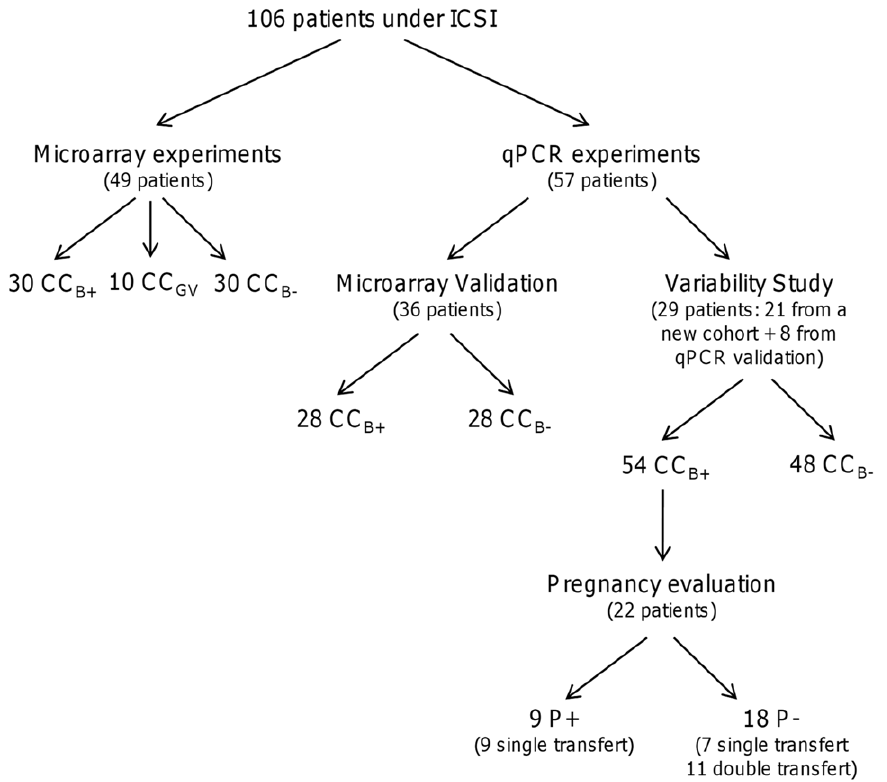
Figure 1. Distribution of patients included in study. Patients were separated into two main groups: microarray and qPCR. The variability group was composed of patients who had one CC B + and at least one CC B- . The pregnancy group was composed of CC B + transferred from patients included in the variability group. CC B + , cumulus cells from a mature oocyte yielding a blastocyst at day 5/6 of in vitro culture once fertilised; CC B- , cumulus cells from mature oocyte which stopped developing at the embryo stage at day 5/6 of in vitro culture once fertilised; CC GV , cumulus cells from immature oocyte at germinal vesicle stage; P + , pregnancy; P-, no pregnancy.